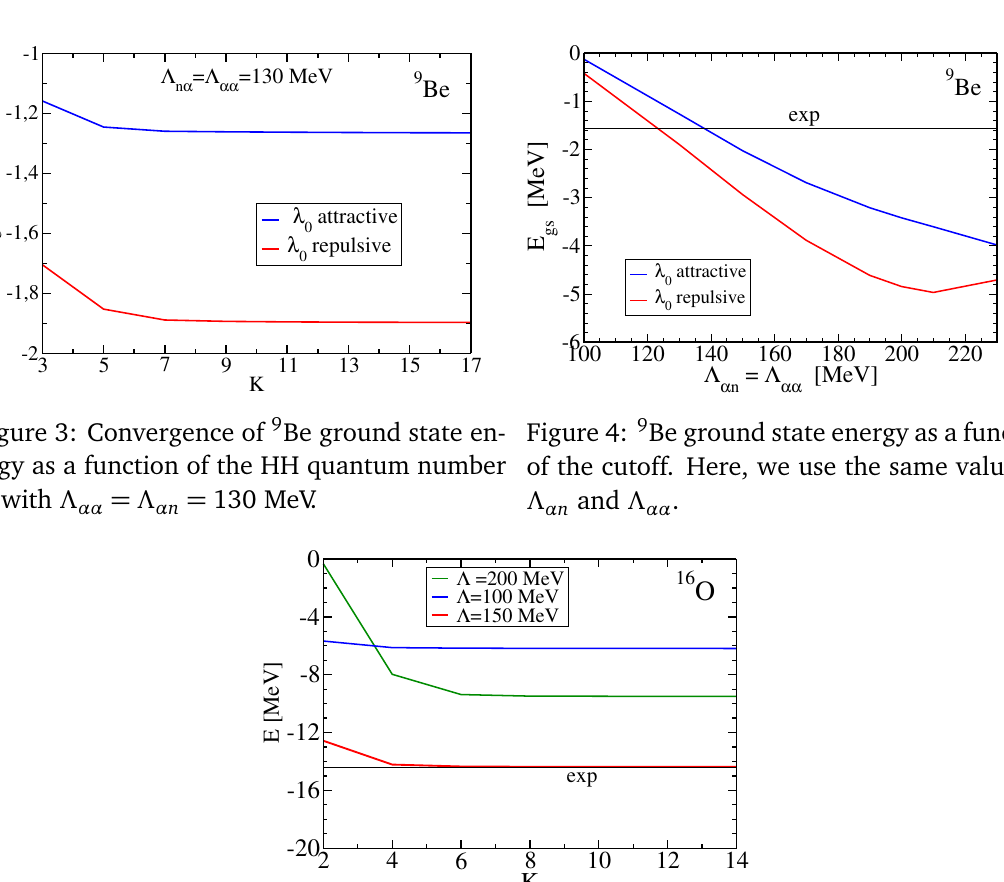
Figure 5: Convergence of 16 O ground state energy as a function of the HH quantum number K for different values of Λ .